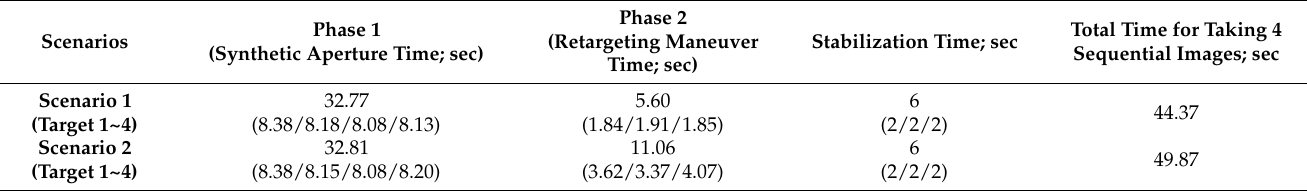
Table 3. Comparison of imaging maneuver time, retargeting maneuver time, and stabilization time in four scenarios.